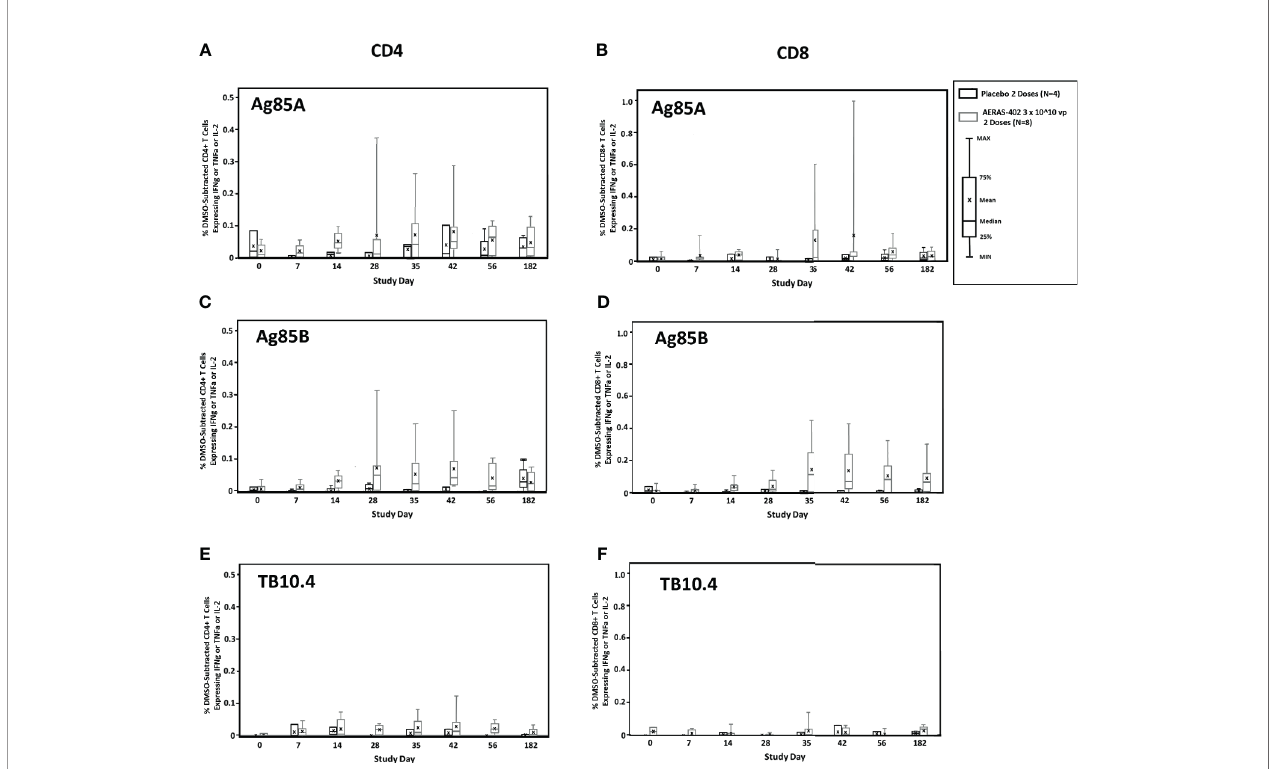
FIGURE 2 | T cell responses to vaccine-encoded antigens. PBMCs were thawed, rested overnight, and stimulated for 5-6 hours with DMSO (negative control), SEB (positive control), or peptide pools corresponding to the vaccine antigens Ag85A (A, B) , Ag85B (C, D) , or TB10.4 (E, F) . Specimens were then stained for viability, phenotypic markers, and intracellular cytokine expression and evaluated by fl ow cytometry. Data were analyzed using FlowJo software to generate cytokine Boolean gates. Each gate was subjected to DMSO subtraction to remove background. Negative results following DMSO-subtraction were set to zero. The sum of these gates was then used to determine the total cytokine response for CD4+ (A, C, E) and CD8+ (B, D, F) T cells for the AERAS-402-vaccinated (grey bars) or placebo control (black bars) groups. Bars are plotted for each group and time point for the total response (any cytokine alone or in combination for IFN- g or IL-2 or TNF- a ). Bars represent the 25 th to 75 th percentile, with the cross bar representing the median response. The mean is indicated by an “ x ” and the error bars represent the minimum and maximum